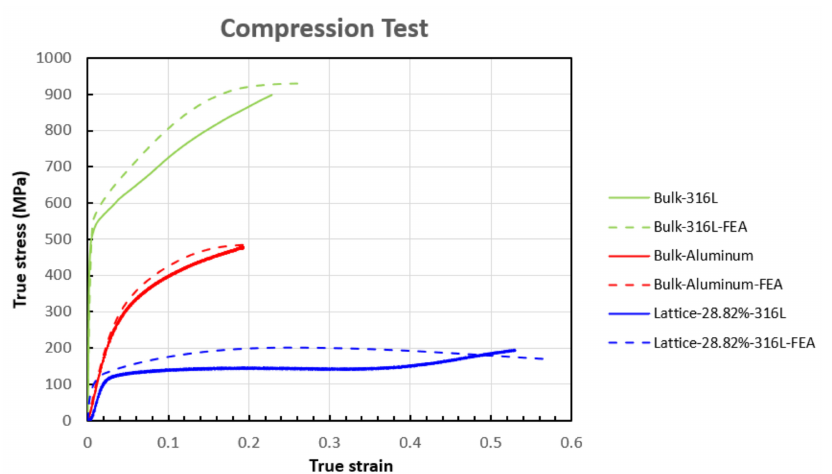
Figure 7. Comparison between experimental and FEA results of bulk 316L stainless steel, bulk dissolvable aluminum, and 316L stainless steel lattice for the compression test.